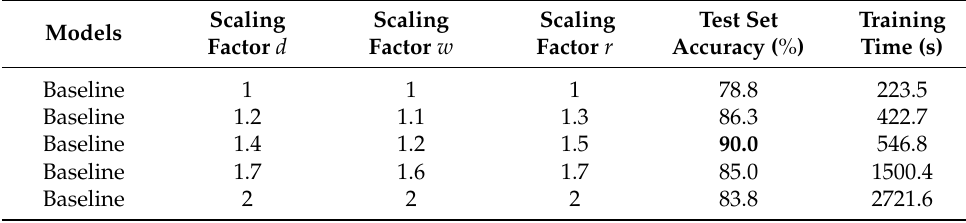
Table 4. Scaling the baseline model with different coefficients.